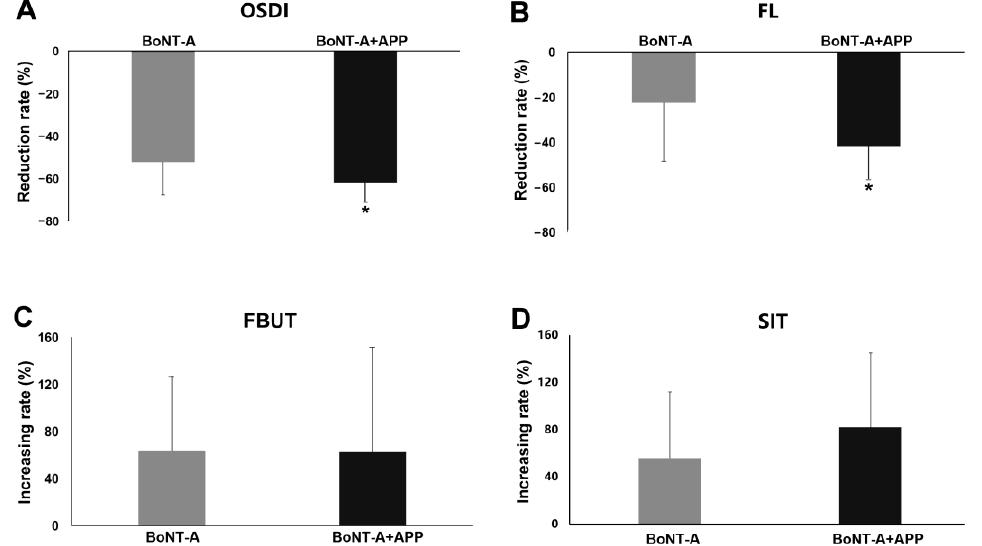
Figure 5. Changing rates (%) of dry eye symptoms and signs in the BoNT-A group and the BoNT- A+APP group before and after treatment. ( A ) OSDI, ( B ) FL, ( C ) FBUT and ( D ) SIT. * p < 0.05.